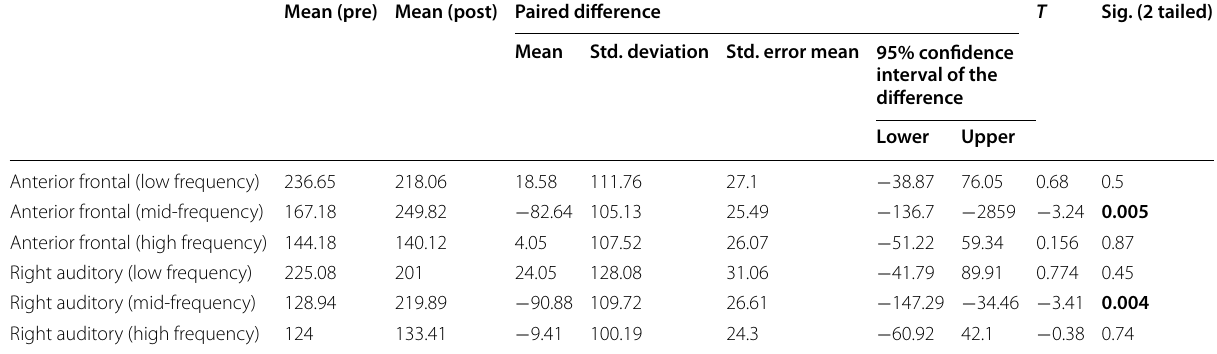
Right auditory (low frequency) 225.08